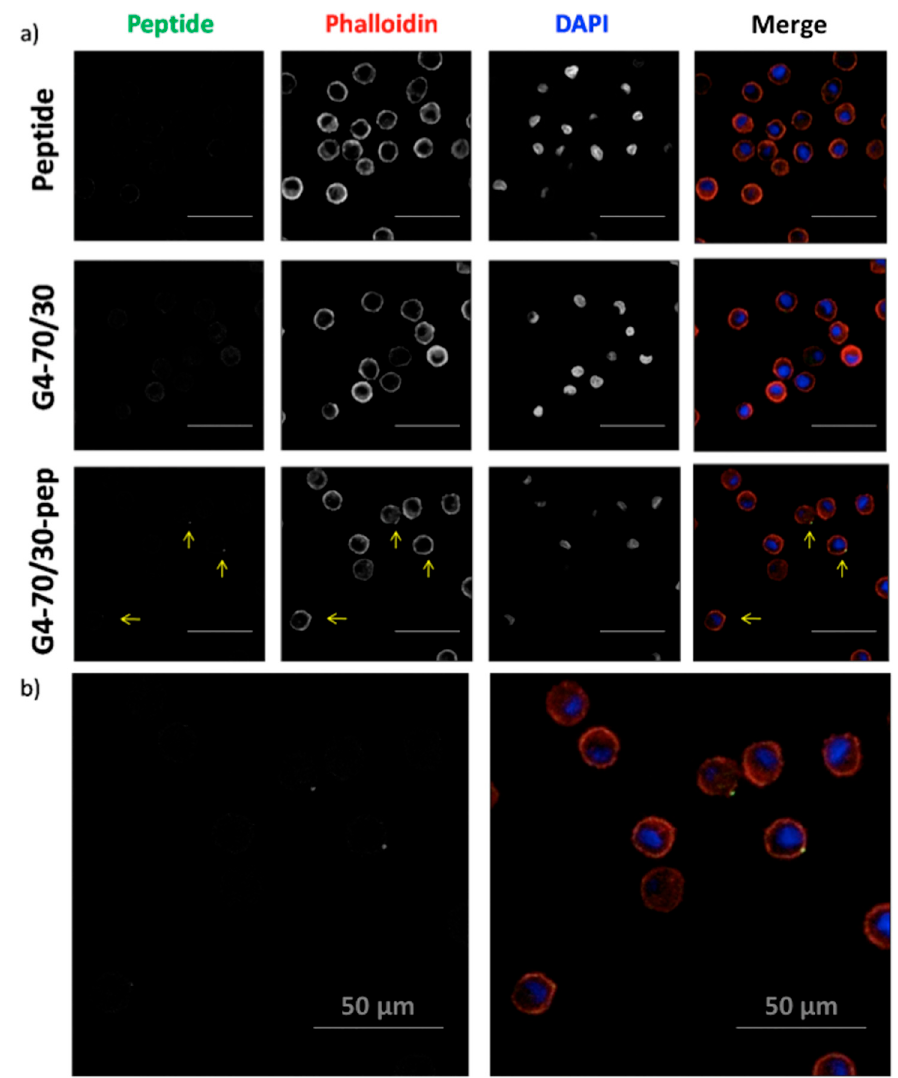
Figure 4. Peptide entry into DCs after 24 h incubation. ( a ) DCs treated with HIV-1 peptide (1 µM), G4-70/30 dendrimer (20 µM) and G4-70/30 (20 µM)-peptide complex, were stained with phalloidin and DAPI and visualized by confocal microscopy. DCs treated with the complex present green fluorescent engrossments where the peptide has entered the cell (arrows). Scale bar: 100 µm ( b ) Enlargement of the images of DCs treated with G4-70/30-peptide complex: green fluorescent peptide (left) and merge (right). Scale bar: 50 µm.